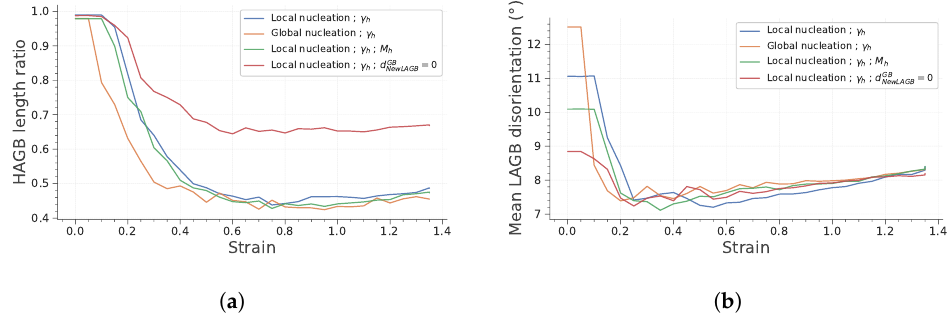
Figure 13. Main microstructural feature evolution with strain during deformation. ( a ) HAGB length ratio. ( b ) Mean LAGB disorientation.